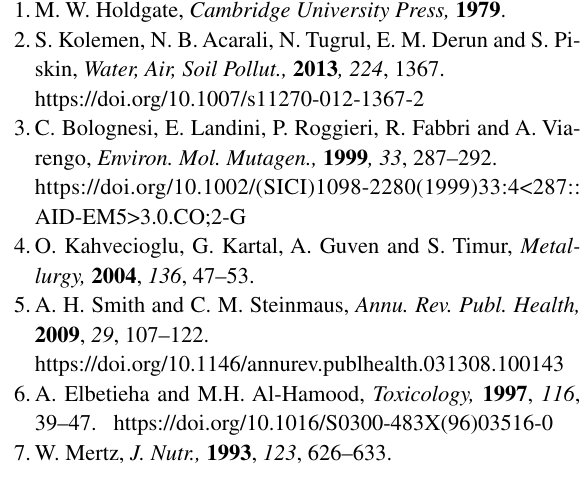
Fig. 5: Plot of ln K ge